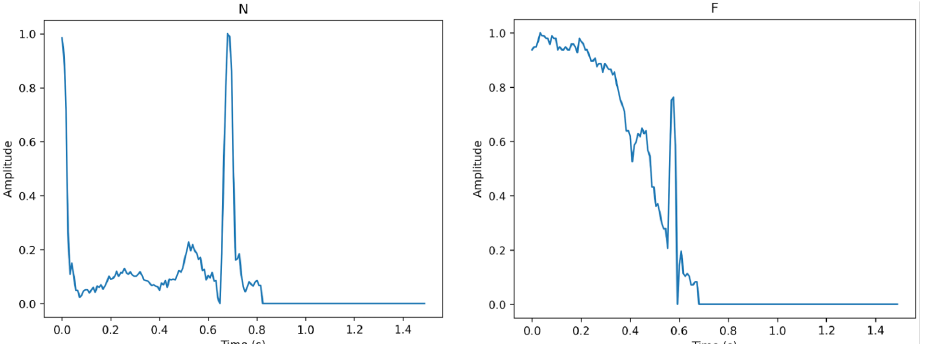
Figure 3. The description of class N ( left ) and class F ( right ).